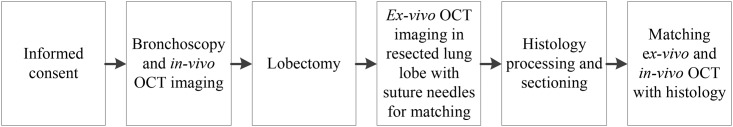
Flow chart of study conduct.